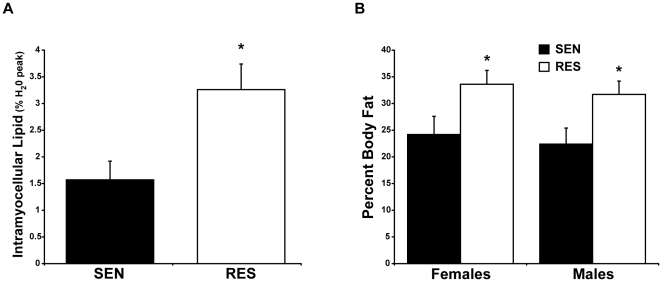
Intramyocellular lipid content and body fat stores are increased in insulin resistant, non-obese subjects.IMCL content of soleus muscles determined by 3D 1H-MRS multiple voxel technique and expressed as percent H2O peak (A). Values for percent body fat as determined by DXA are plotted separately males and females to show the independence of gender on the relationship between adipose stores and insulin action (B). Insulin sensitive (black bars) and resistant (white bars) groups are segregated based on results from hyperinsulinemic, euglycemic clamp as described. Values shown are mean ± SEM. *P<0.05, RES vs. SEN groups.